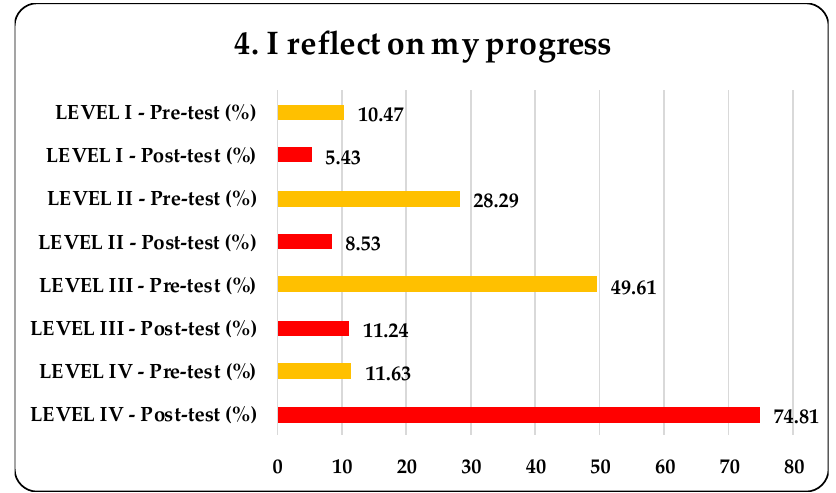
Figure 8. Levels of achievement of the third dimension: How I learn (%).